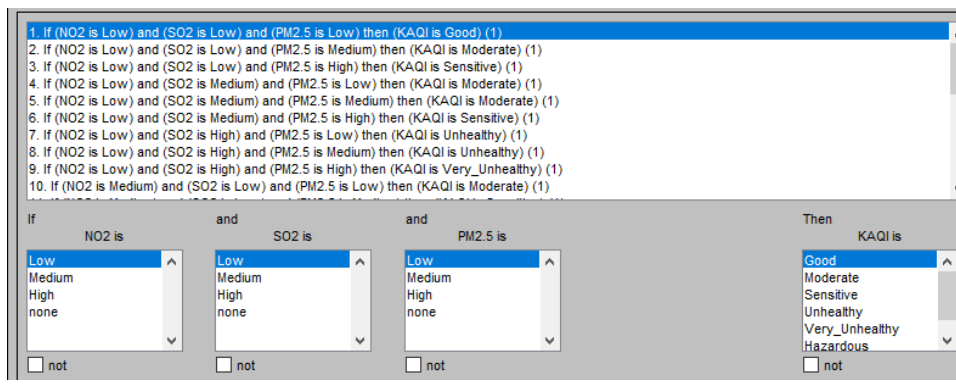
Figure 8. MATLAB evaluation inference rules editor view design for NO 2 , SO 2 , PM 2.5 vs. KAQI.